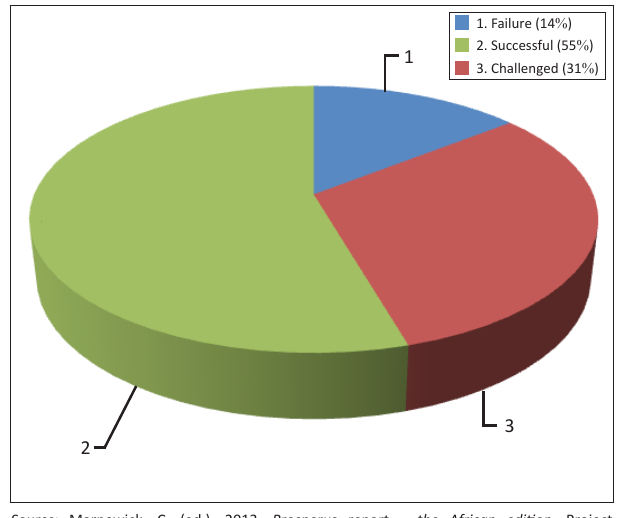
FIGURE 1: Information technology related project success